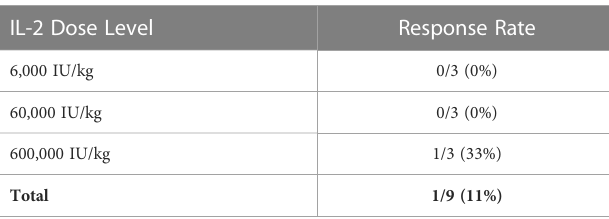
TABLE 4 Best overall response rate by IL-2 dosing cohort.